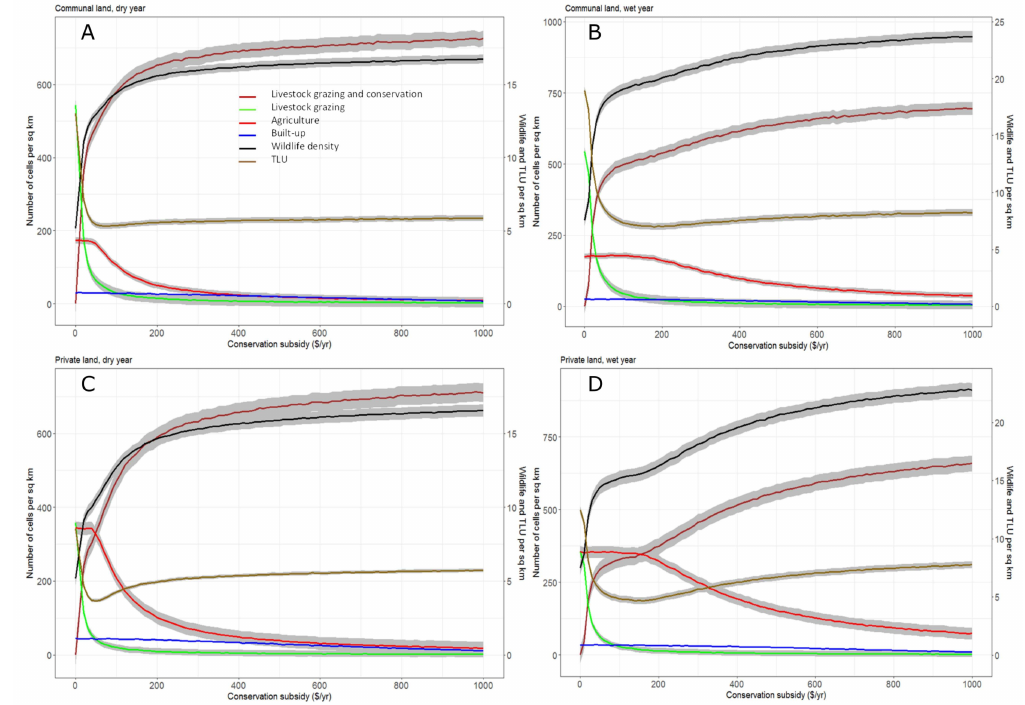
Figure 3. Trends in the relationship between land use types, wildlife and livestock density (TLU) in Amboseli. Figure ( A , B ) show dry and wet year trends under the communal land tenure scenario while figures ( C , D ) show dry and wet year trends under the private land tenure scenario. In all the figures, the grey zones represent the 95% confidence interval. From the figures, animal density increases with conservation subsidies though at different levels under different rainfall years and land tenure